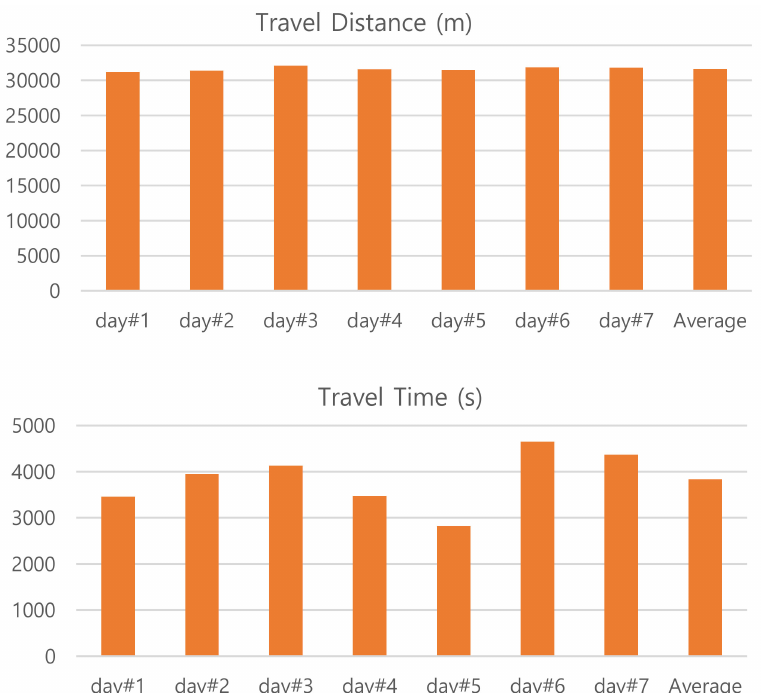
Figure 3. User’s commute data of seven days are summarized with respect to distance and